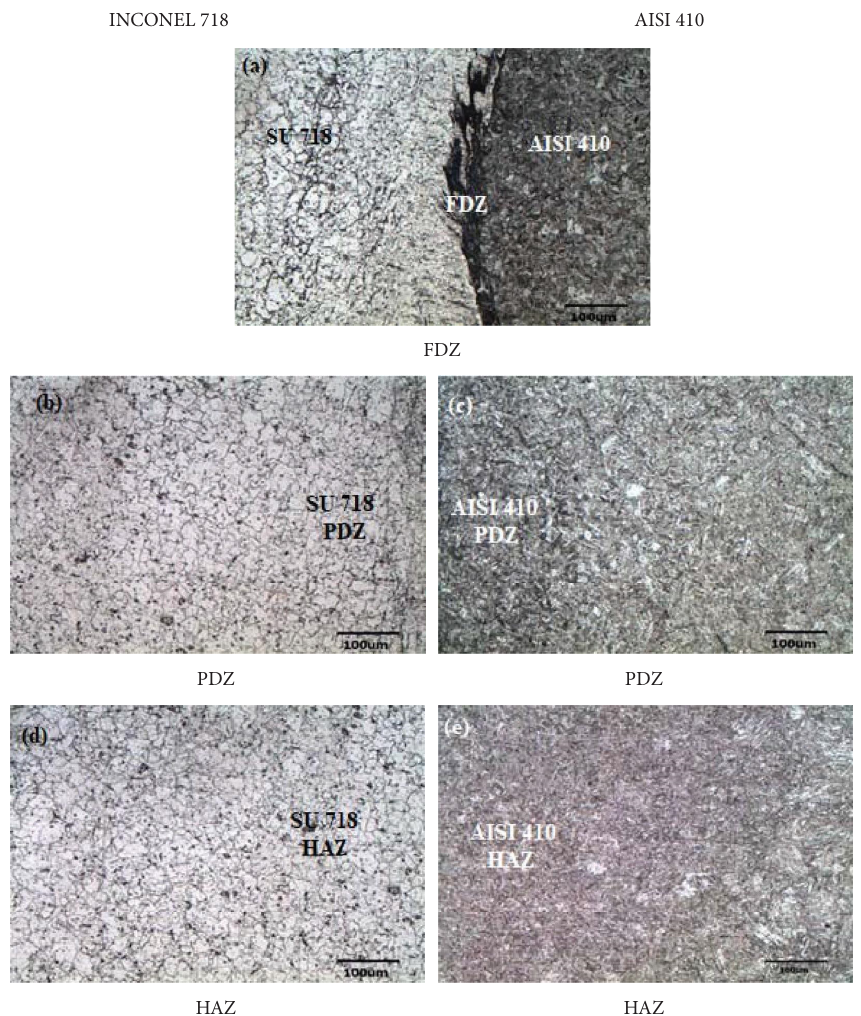
Figure 9: Dissimilar weld joint microstructure at 1500rpm.